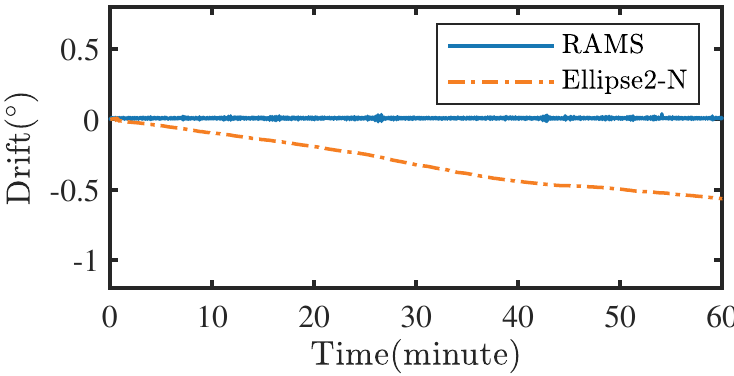
Figure 13. Drift of the Ellipse2-N and RAMS were left to stand for one minute. The maximum measurement error for different angles is also an important indicator of system performance. As shown in Figure 14, the maximum measurement error of RAMS for various angles did not exceed 0.05 ◦ .